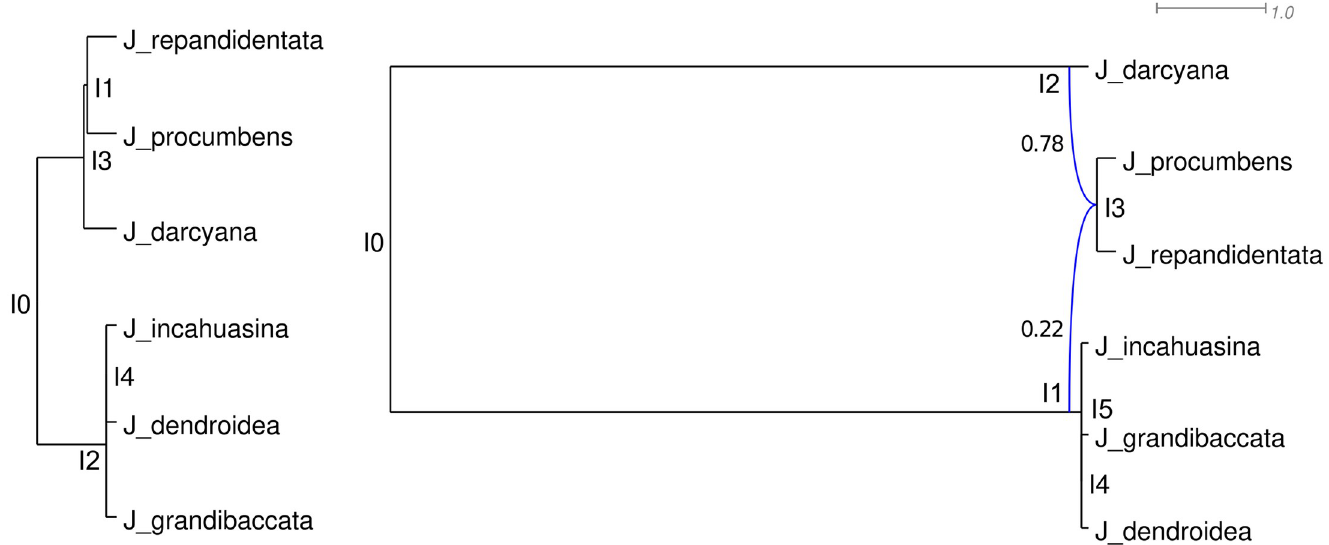
Fig 5. Inferred species tree (left) and network (right) of the Jaltomata data set. The major tree inside the species network is obtained by removing the blue reticulation edge leading to I1.